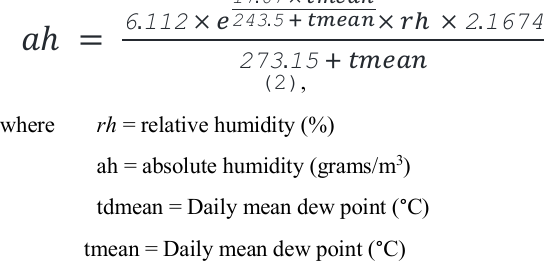
Figure 5 . RINX Output Data